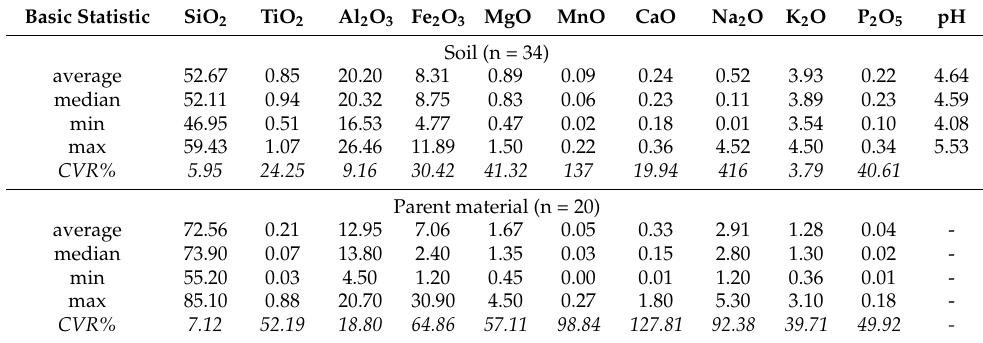
Table 4. The basic statistical parameters for the geochemical composition of soil and parent